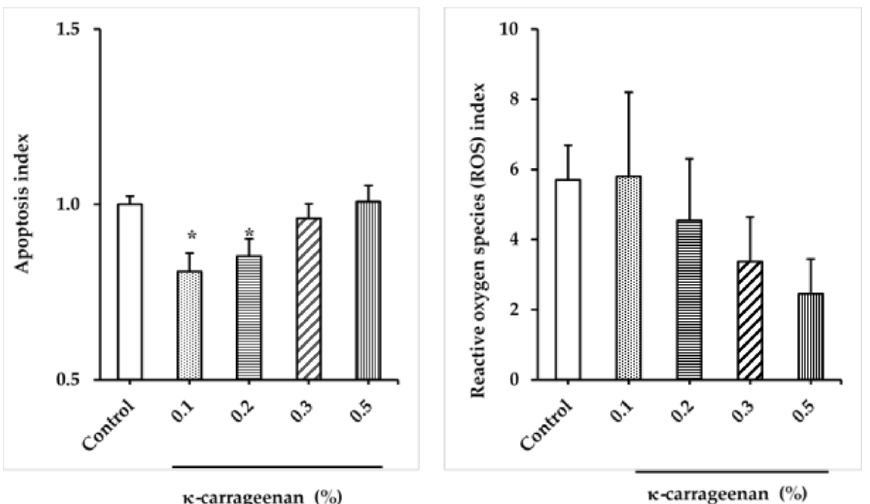
Figure 3. Effect of different κ -carrageenan concentrations in egg yolk-free extender on the apop- tosis and the reactive oxygen species (ROS) levels of canine sperm following